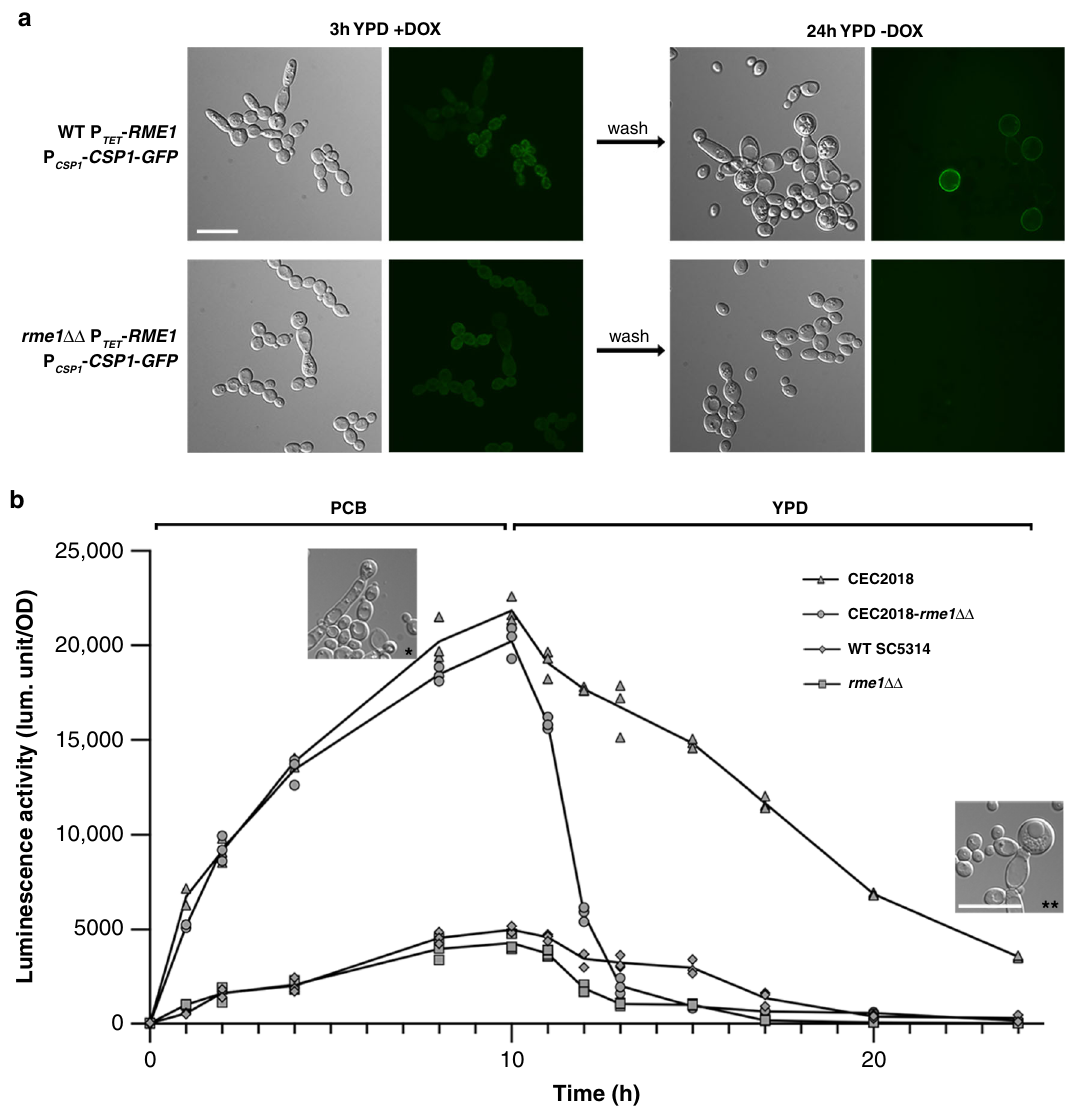
Fig. 5 Rme1 positively regulates its own expression. a RME1 native promoter is positively regulated by the ectopic expression of RME1 in C. albicans WT strain. C. albicans WT and rme1 ΔΔ strains expressing P TET - RME1 and CSP1 - GFP (CEC4827 and CEC4789, respectively) were grown in liquid doxycycline- containing YPD ( + dox) at 30 °C for 3 h, then cells were centrifuged, washed and resuspended in fresh YPD without doxycycline and incubated overnight at 30 °C. Scale bar = 10 μ m. b RME1 expression is controlled by Rme1 endogenously expressed under harsh conditions. Luciferase activity levels were measured in C. albicans strains expressing the P RME1 -gLUC fusion. After a 10-h incubation at 25 °C in liquid PCB medium, cells were transferred to fresh YPD medium and incubated for 14 h. Aliquots were taken at the indicated time points ( x -axis) and the data presented are the recorded luciferase activity levels ( y -axis). The values of three independent replicates are plotted ( n = 3). Inset pictures show CEC2018 cells after a 10-h incubation in PCB (*) or after the following overnight incubation in YPD (**). Both images are at the same scale. Scale bar = 10 μ